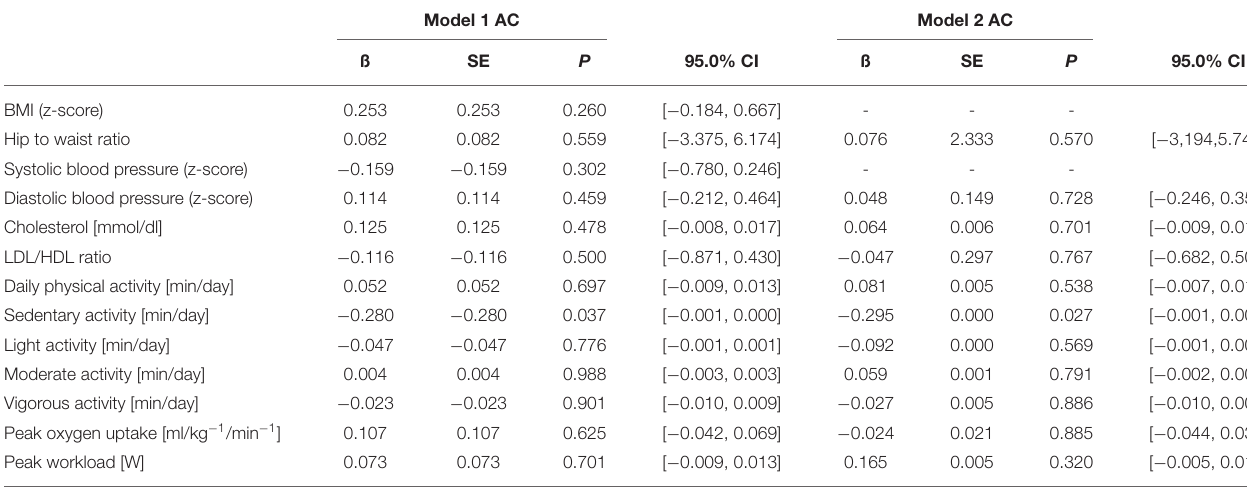
TABLE 3 | Multivariable correlates of arterial compliance.